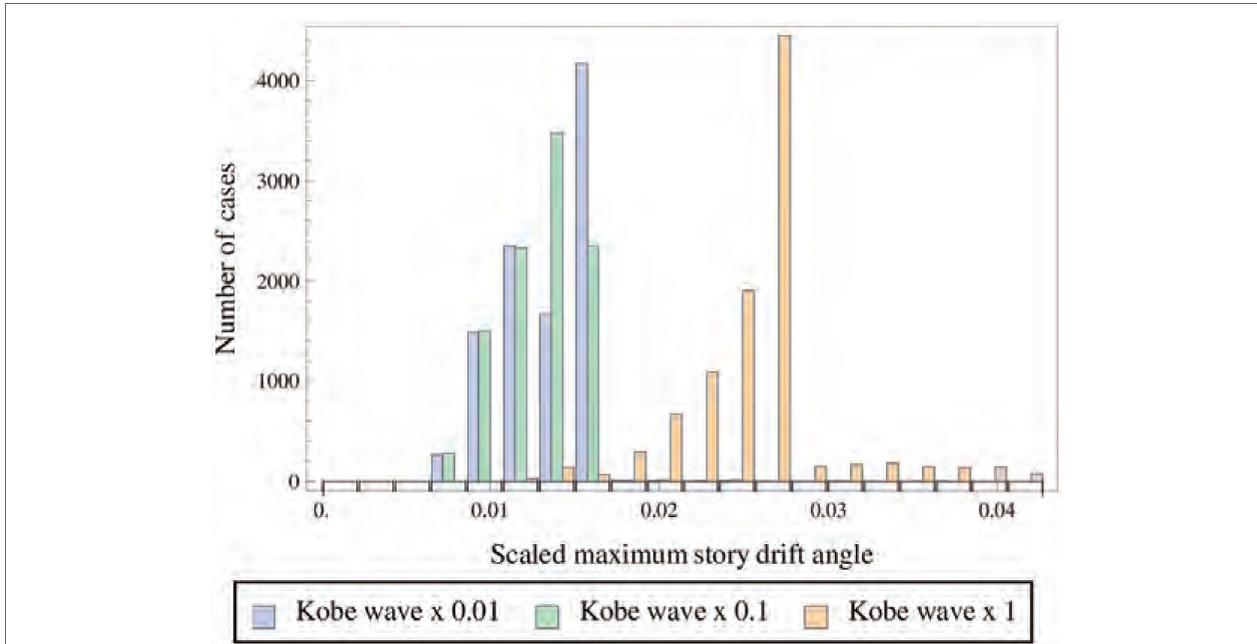
FigUre 11 | Distribution of MSDA for 10,000 analysis models for one residential building.